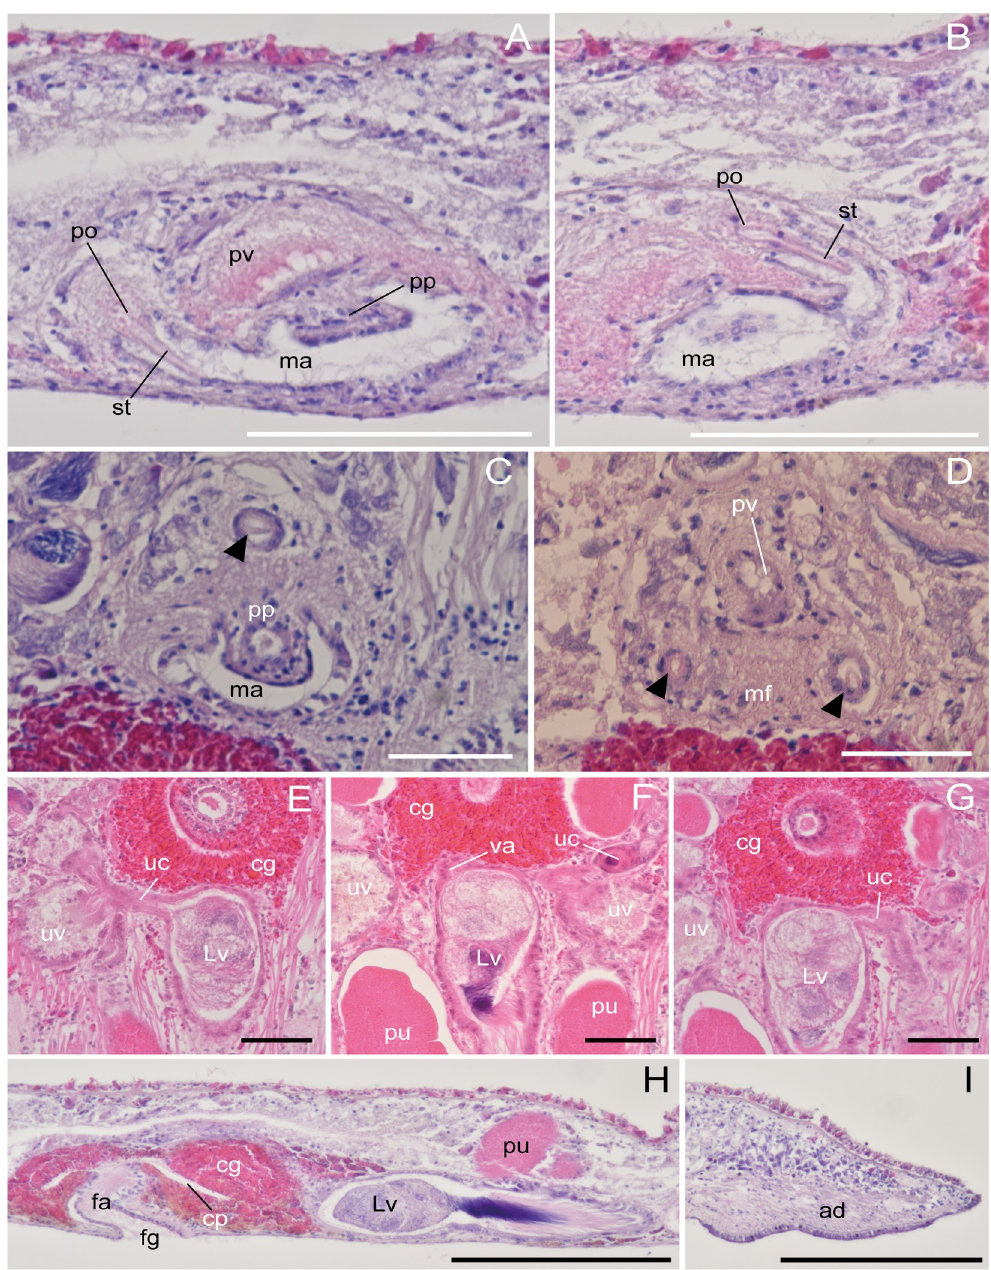
Fig 3. Boninia uru sp. nov.: Photomicrographs of sagittal (A, B, H, I) and horizontal (C–G) sections. (A, B) ICHUM 8278 (holotype), male copulatory apparatus, anterior to the left; (C, D) ICHUM 8279 (paratype), male copulatory apparatus, with stylet of the prostatoid organ indicated by arrowheads; (E–G) ICHUM 8283 (paratype), connection between uterine canal and Lang’s vesicle; (H) ICHUM 8278 (holotype), female copulatory complex; (I) ICHUM 8278 (holotype), adhesive organ. Abbreviations: ad, adhesive organ; cg, cement glands; cp, cement pouch; fa, female atrium; fg, female gonopore; Lv, Lang’s vesicle; ma, male atrium; mf, muscle fiber; po, prostatoid organ(s); pp, penis papilla; pu, posterior dilations of uteri; pv, prostatoid vesicle; st, stylet; uc, uterine canal; uv, uterine vesicle. Scale bars: A, B, 100 μ m; C–G, 50 μ m; H, I, 200 μ m. between B . uru sp. nov. and its congeners. The new species and B . neotethydis are distin- guished from the other species of Boninia by having just four cerebral eyespots (Table 4), and they are distinguished from each other in terms of the number of marginal eyespots (21–29 in